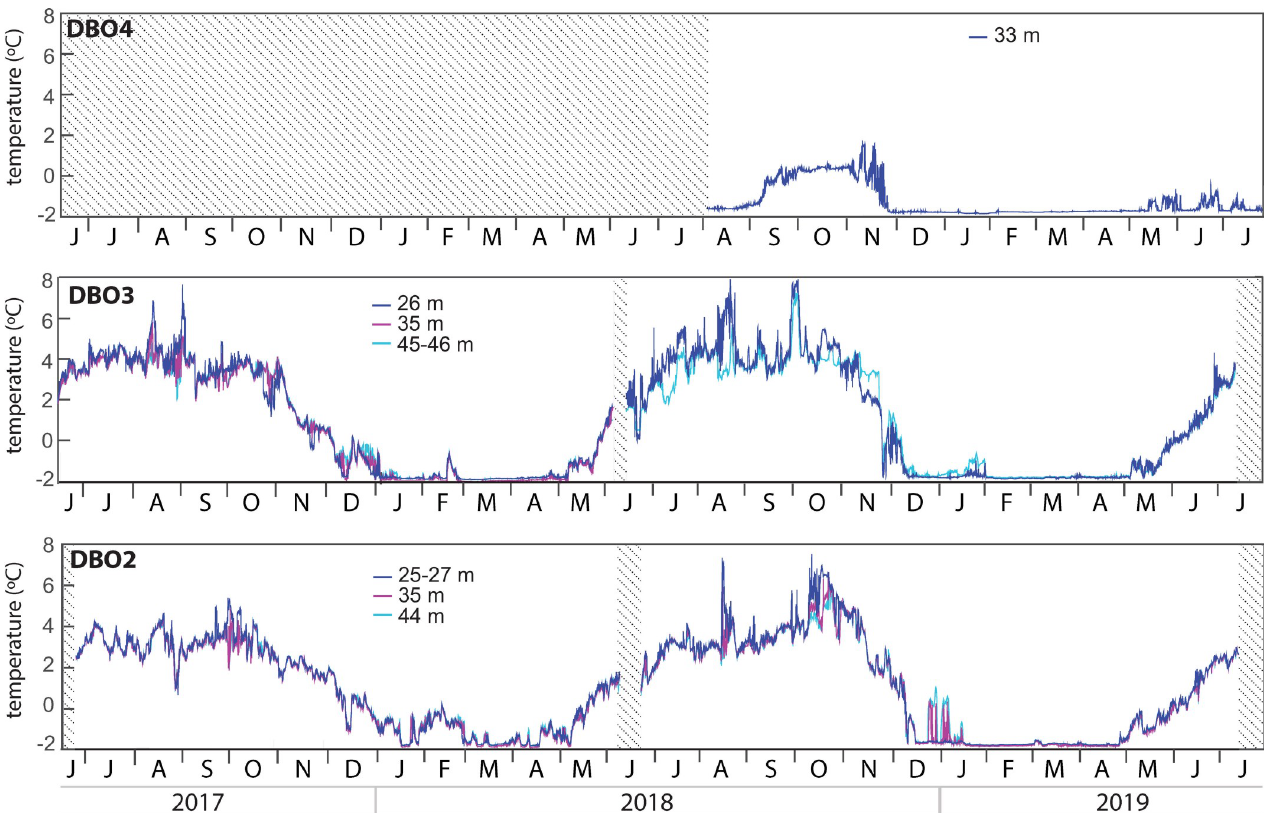
Fig 3. Water temperatures at each mooring site. There are no available data at 35 m for the 2018–2019 cycle at DBO3. Shaded areas represent periods without